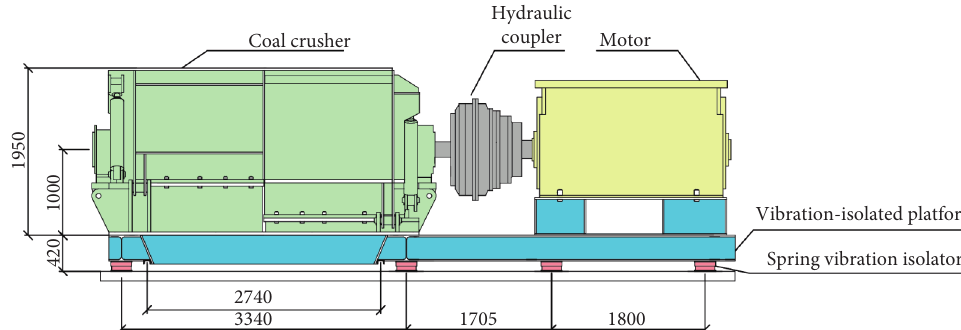
Figure 2: Coal crusher system.